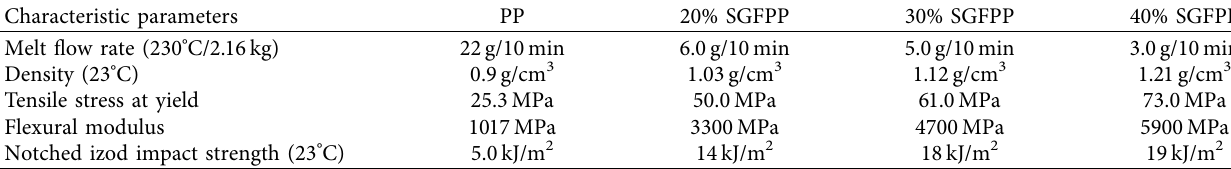
Table 2: Characteristics of polypropylene-based short fiber composites.